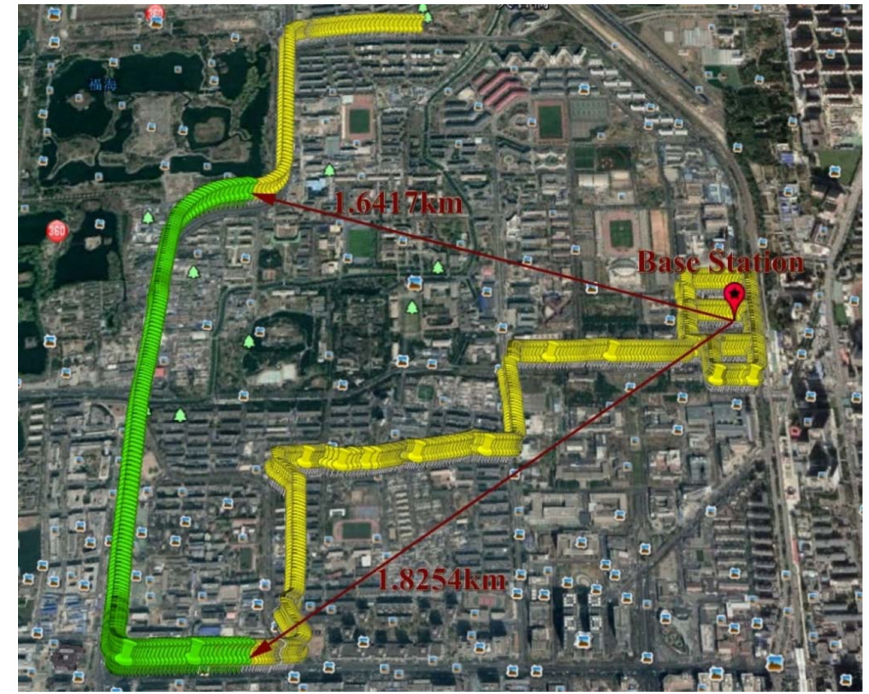
Figure 14. The entire path obtained by Inertial Explorer as a reference (from Google Earth).